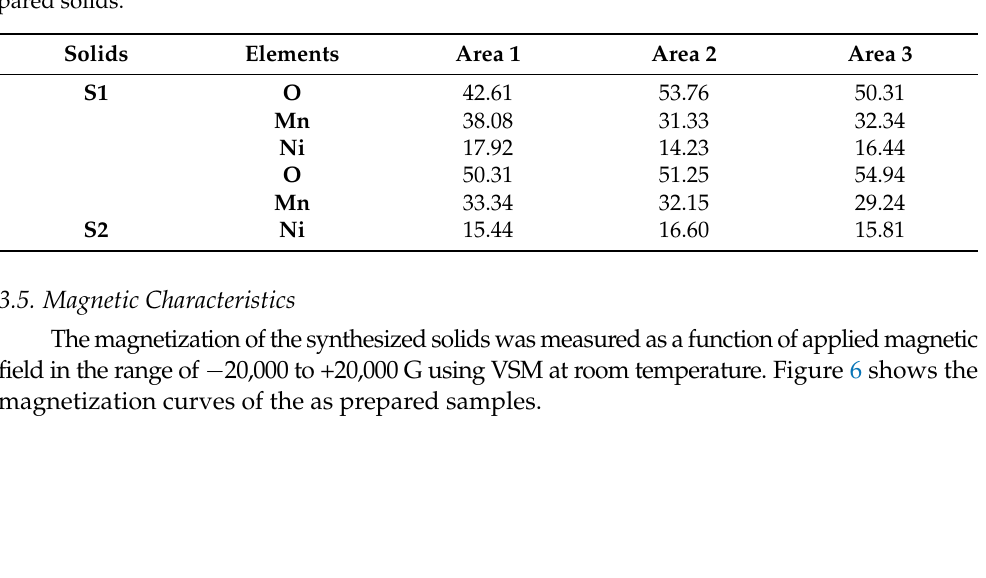
Table 1. Atomic abundance of elements measured at 20 keV and different areas over the as pre- pared